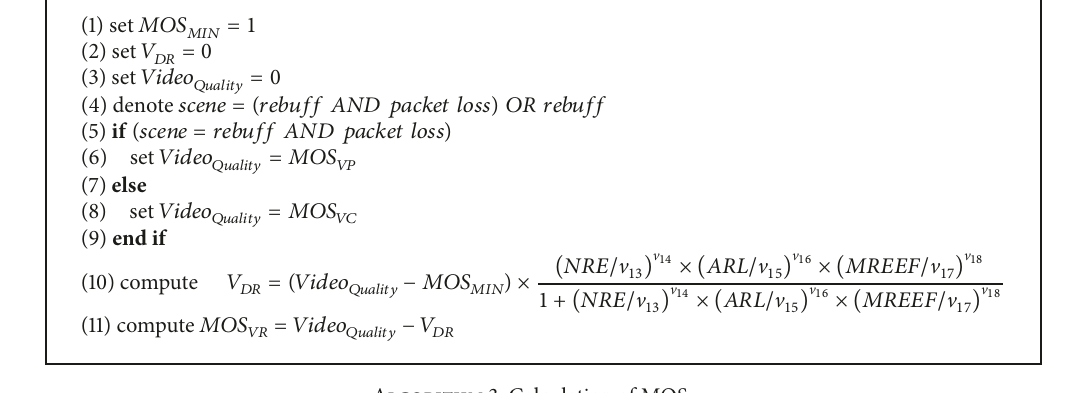
Algorithm 3: Calculation of MOS Table 9: Application areas, test factors, and technology used by the ITU-T P.1201.1